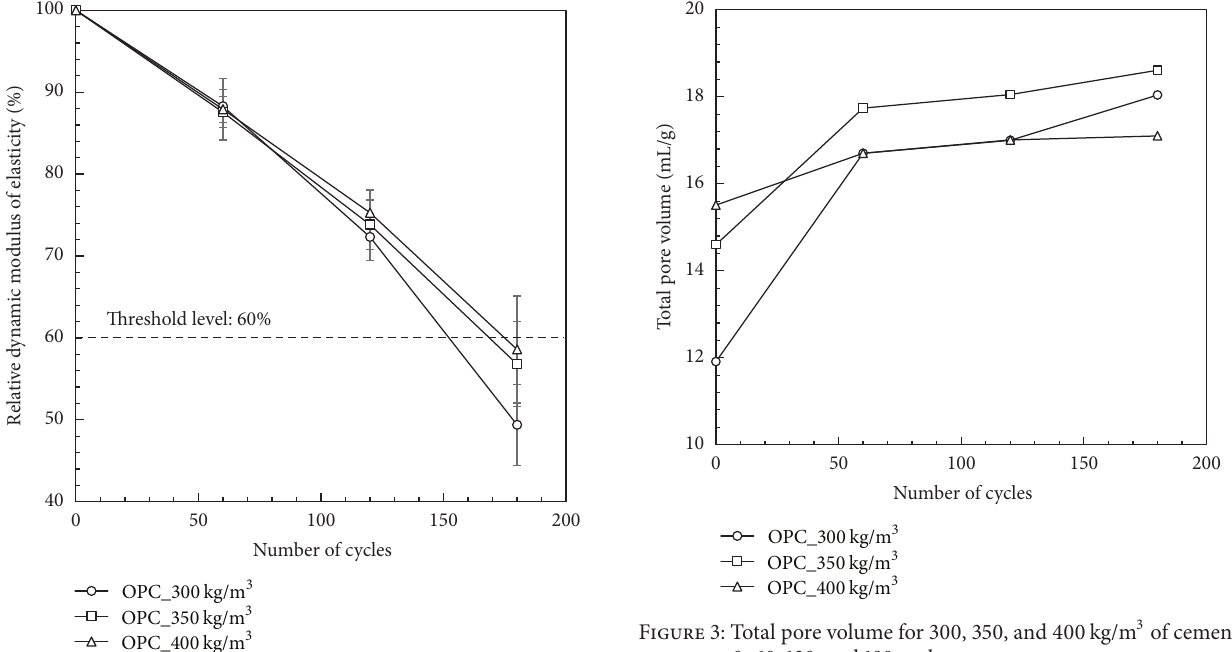
Figure 2: The relative dynamic modulus of elasticity under freeze- thaw condition.